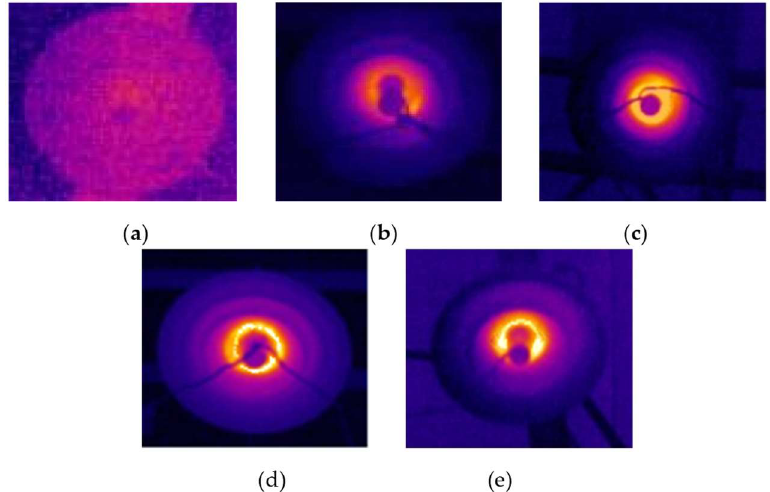
Figure 2. Infrared images of wet contaminated insulators. ( a ) Clean insulator; ( b ) Insulator of contamination grade Ⅰ ; ( c ) Insulator of contamination grade Ⅱ ; ( d ) Insulator of contamination grade Ⅲ ; and ( e ) Insulator of contamination grade Ⅳ .